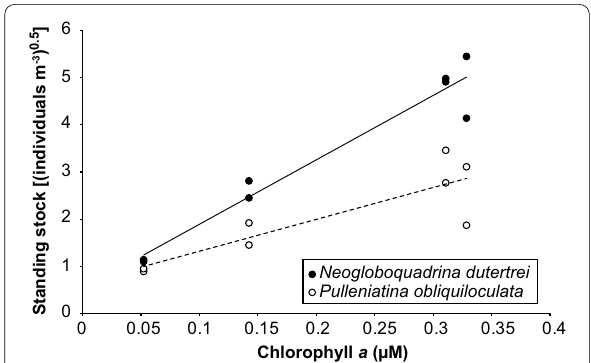
Fig. 5 Correlations of standing stocks of two non-spinose planktonic foraminiferal species ( Neogloboquadrina dutertrei and Pulleniatina obliquiloculata ) with chlorophyll a